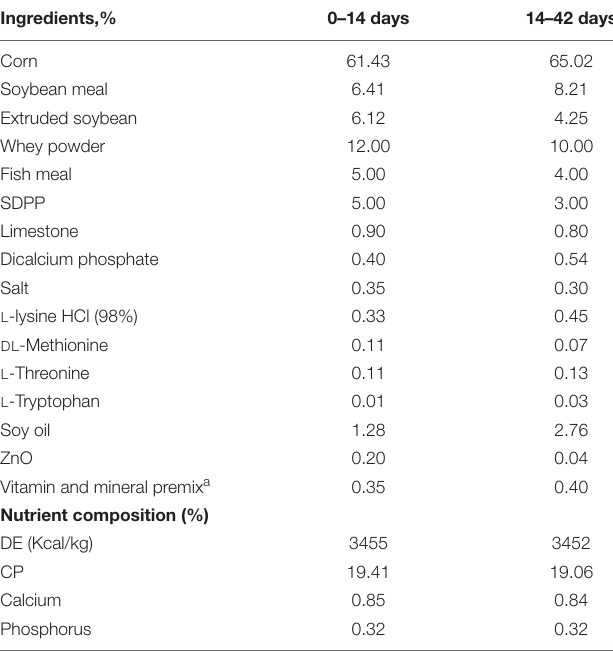
TABLE 1 | Ingredients and composition of the basal diet for C (control).